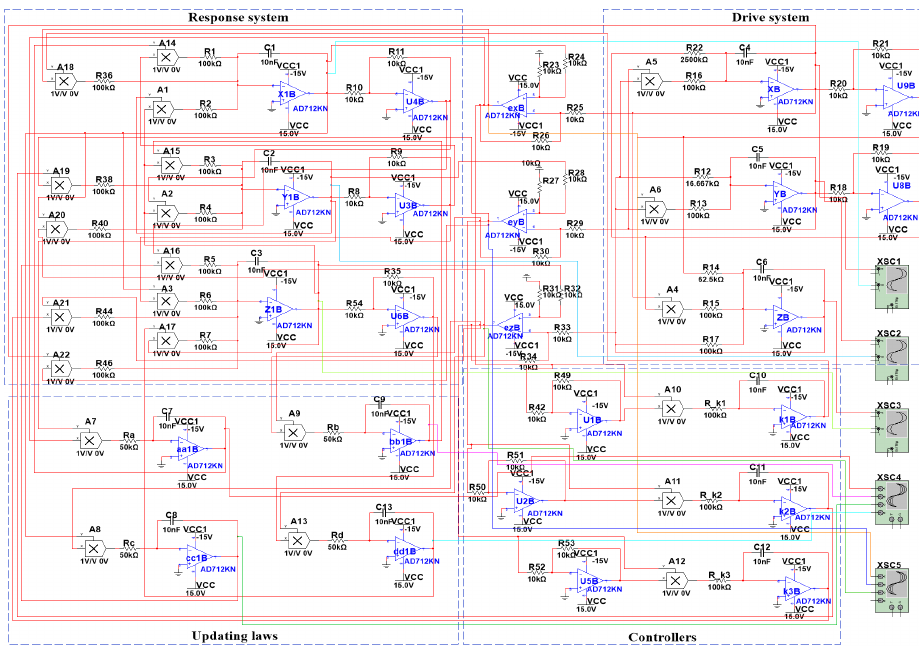
Figure 13. Electronic circuit schematics of the parameter identification.